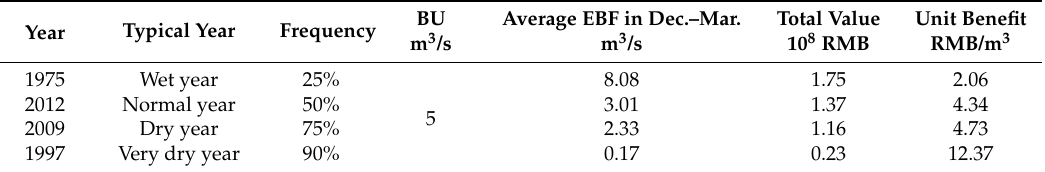
Table 7. The total value and the unit benefit of EBF in typical years in the upstream. “BU” represents the baseline of the upstream section (5 m 3